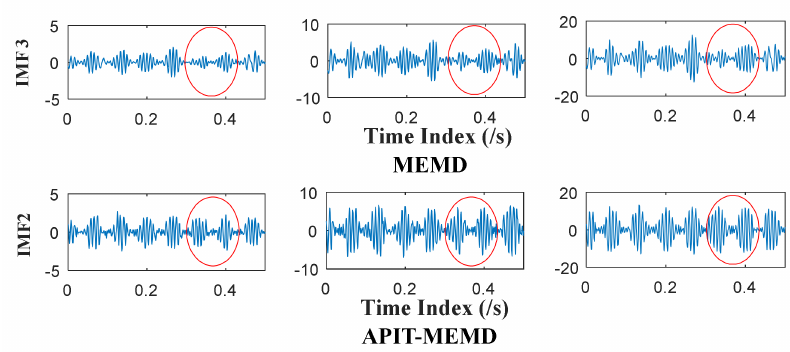
Figure 12. Selected time domain plots of IMFs of MEMD and